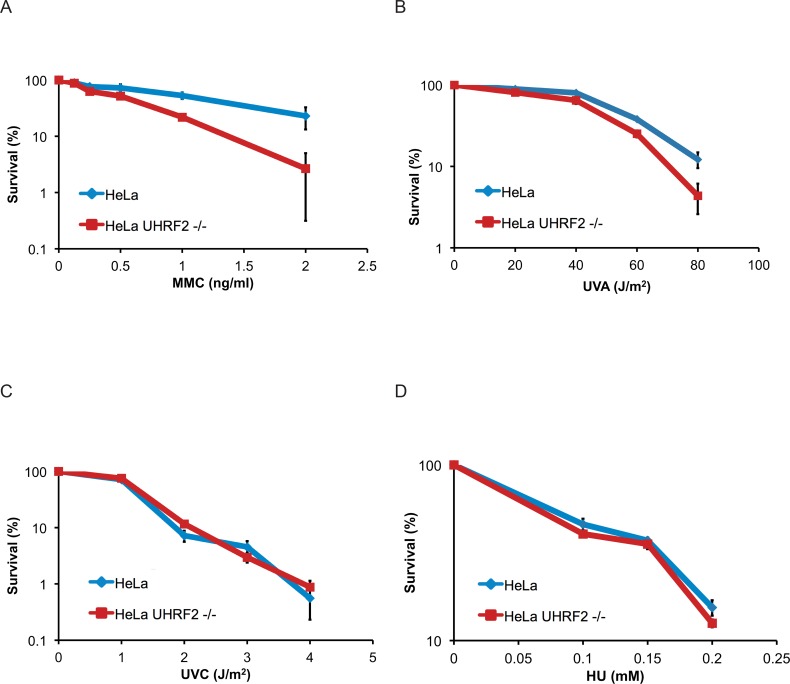
Depletion of UHRF2 reduces cell survival in response to ICL-causing agents.A) Clonogenic survival assay of HeLa and HeLa UHRF2-/- cells in response to MMC. Depletion of UHRF2 reduces cell survival. Experiment was repeated 3 times, each with a p-value <0.01 at 2 ng/ml MMC. B) Clonogenic survival assay of HeLa and HeLa UHRF2 -/- cells in response to TMP/UVA. Depletion of UHRF2 reduces cell survival. Experiment was repeated 2 times, each with a p-value <0.01 at 80 J/m2. C) Clonogenic survival assay of HeLa and HeLa UHRF2-/- cells in response to UVC. Experiment was performed once in triplicate. D) Clonogenic survival assay of HeLa and HeLa UHRF2-/- cells in response to HU. Experiment was performed once in triplicate.